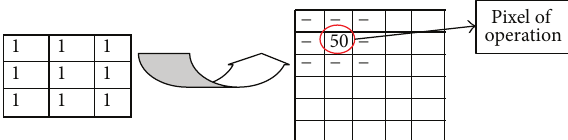
extraction, blots area calculation, and 𝑘 -mean clustering for extraction of different clusters due to different diseases. (1) Color Extraction. Any RGB image is a combination of red, green, and blue colors according to standard color space. So, it is advisable to extract percentage of red, green, and blue